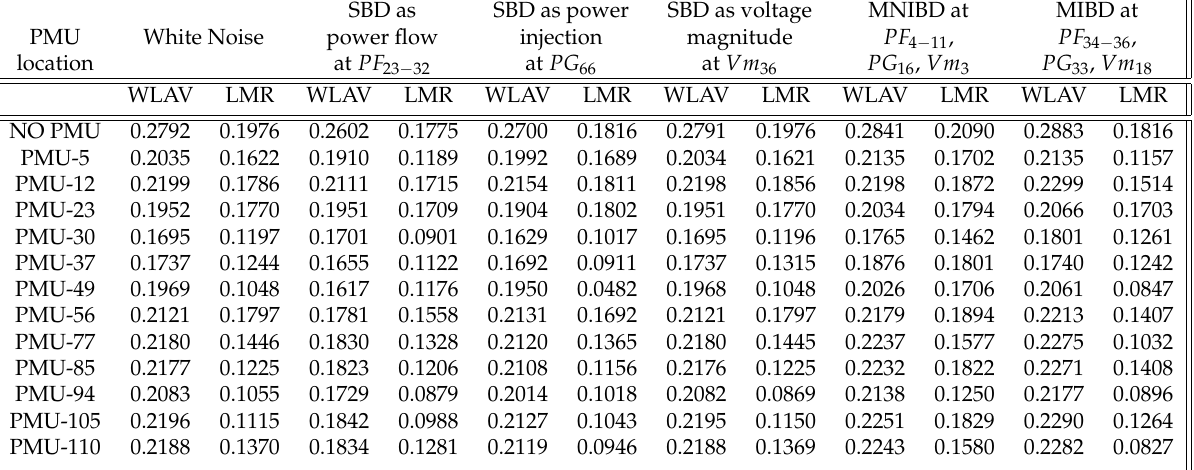
Table 10. IEEE 118 Bus - Absolute voltage magnitude (AVM) error